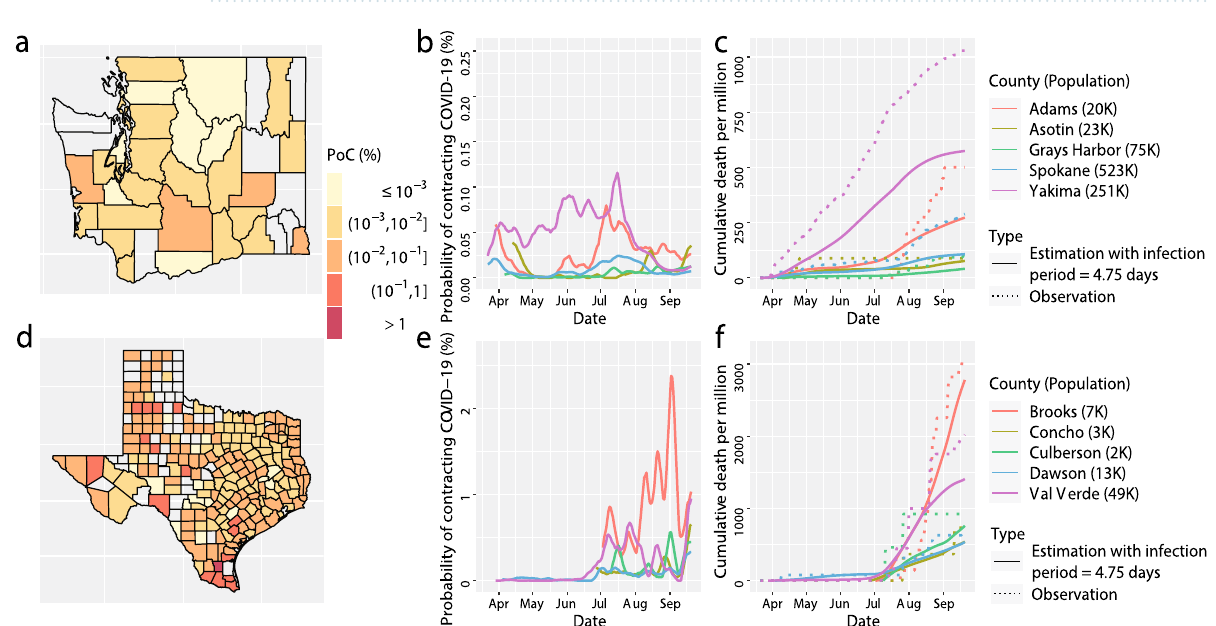
Figure 10. ( a – f ) The simulated results of COVID-19 progression in Washington (the first row) and in Texas (the second row) that have the same interpretation as ( a – f ) in Fig. 4 with the infection period changed from 5 days, to 4.75 days, whereas other parameters are held the